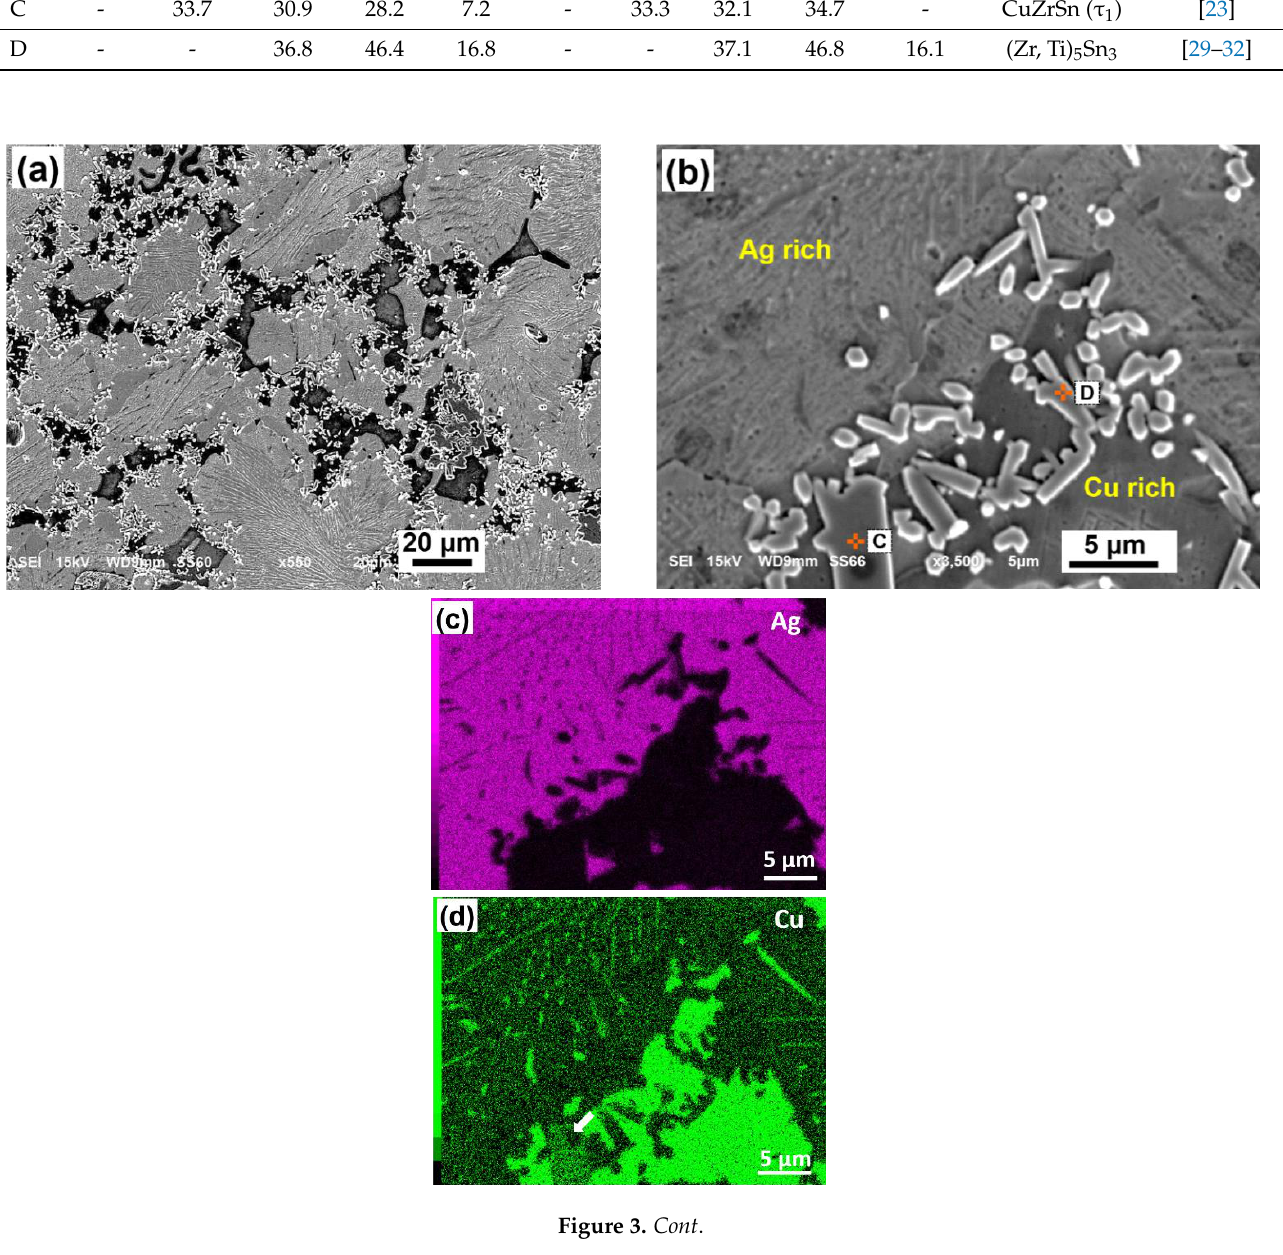
Table 2. Quantification of possible phases formed in Ag-18Cu-6Sn-3Zr and Ag-18Cu-6Sn-3Zr-1Ti alloy. Nominal Composition from EDS (at.%) Spot